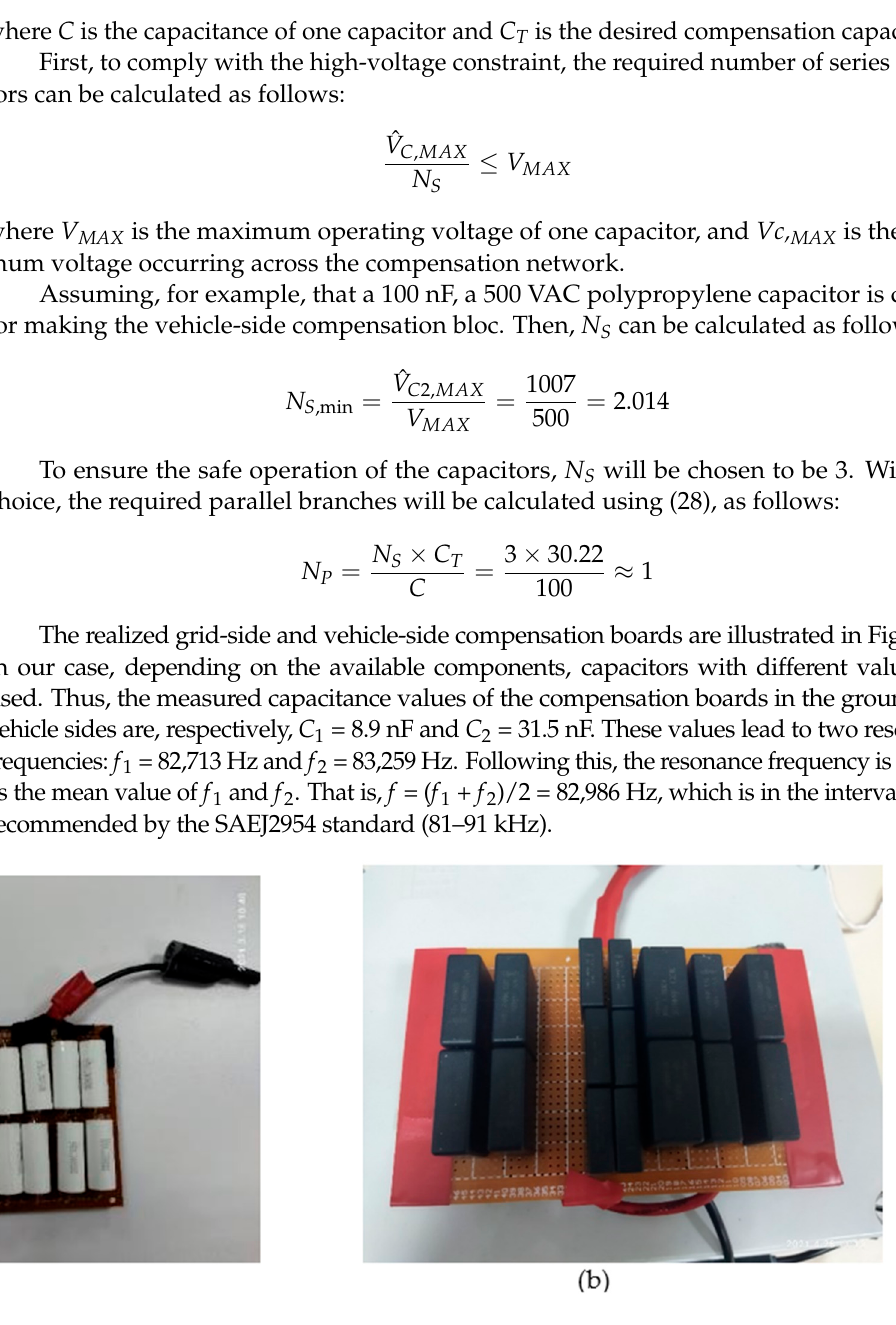
Figure 22. Images of the realized compensation boards ( a ): in the vehicle side and ( b ): in the ground side.